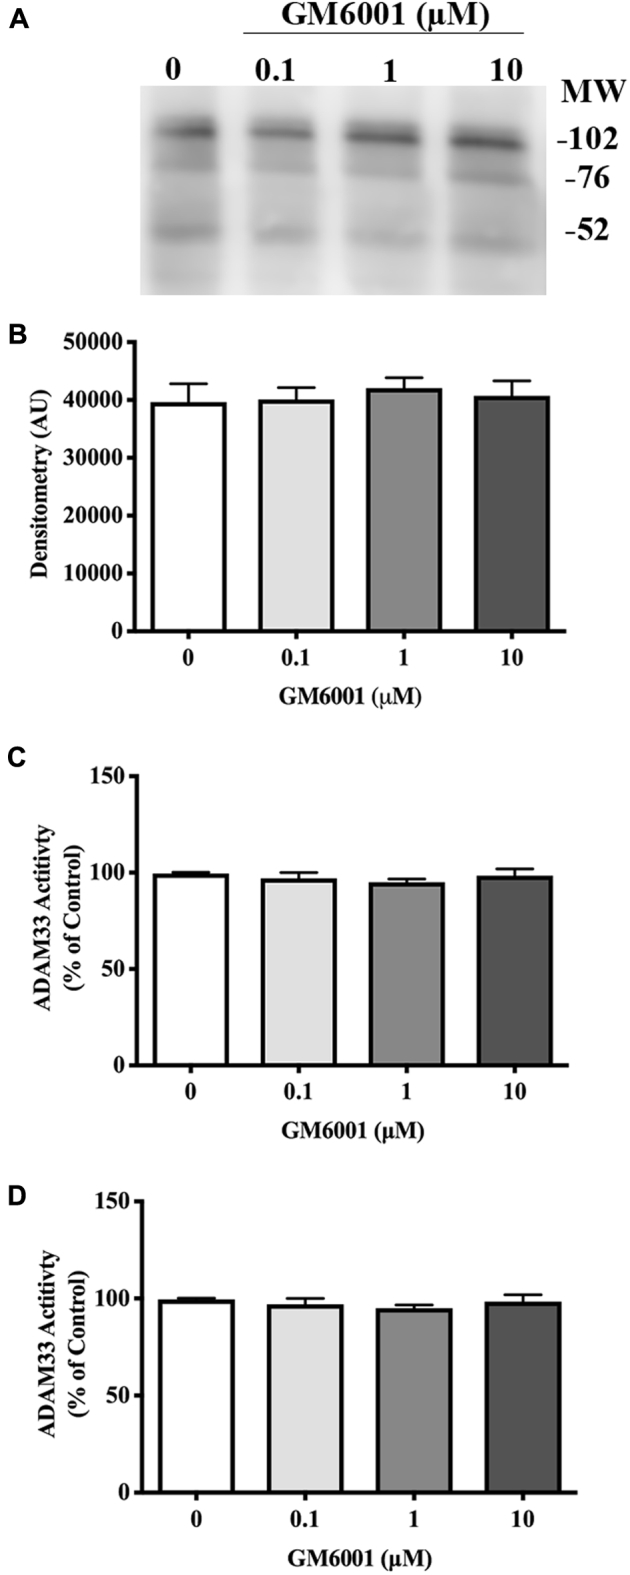
The broad-spectrum MMP inhibitor GM6001 does not inhibit ADAM33 shedding. Cos-7 cells transiently transfected with full-length murine ADAM33 were preincubated with GM6001 (0-10 μM) for 1 hour before addition of 5 ng/mL TGF-β for 8 hours. Cell-free supernatants were assessed for soluble ADAM33 by Western blotting (A) with densitometry (arbitrary units, AU) (B) and by fluorescence resonance energy transfer peptide cleavage assay (C). Purified recombinant ADAM33 protein was incubated with GM6001 and tested for activity in a fluorescence resonance energy transfer peptide cleavage assay (D). Activity is presented as a percent of that measured in the absence of GM6001. MW, Molecular weight. Data are expressed as mean + SD and are representative of 4 independent experiments.